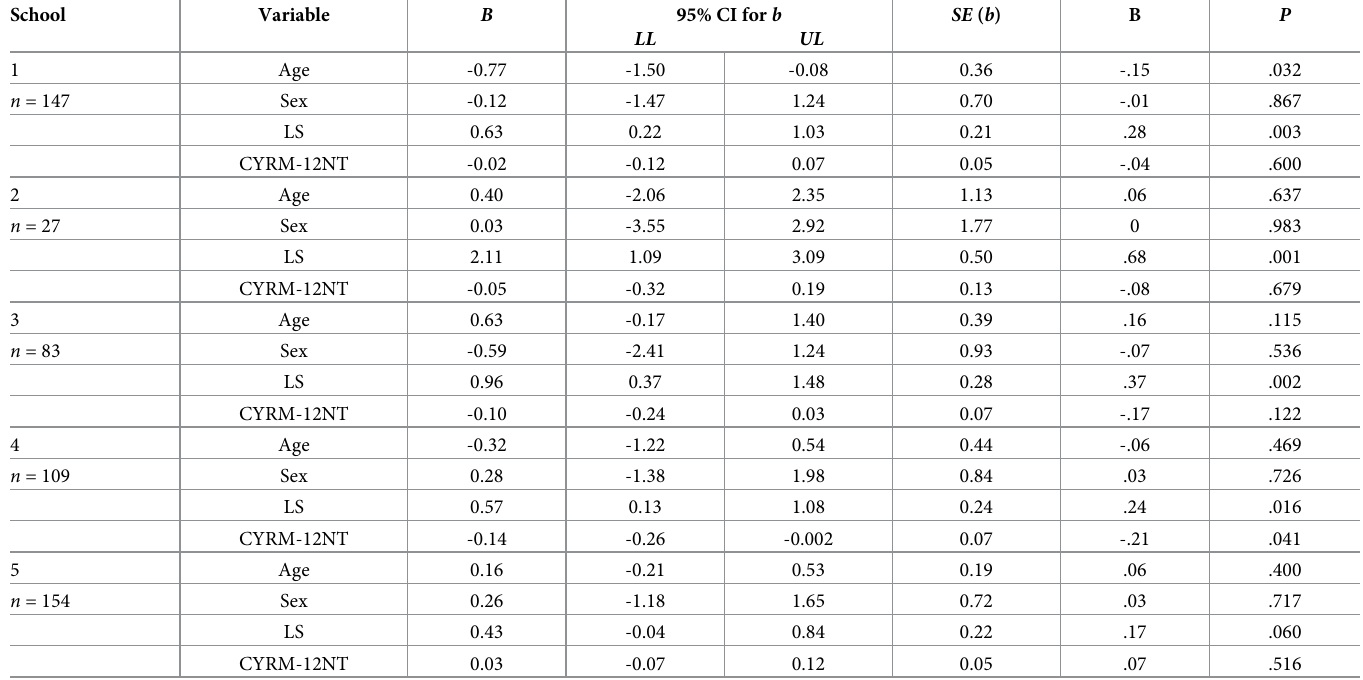
Table 7. Multiple regression analysis results by school explaining K6 with CYRM-12NT and control